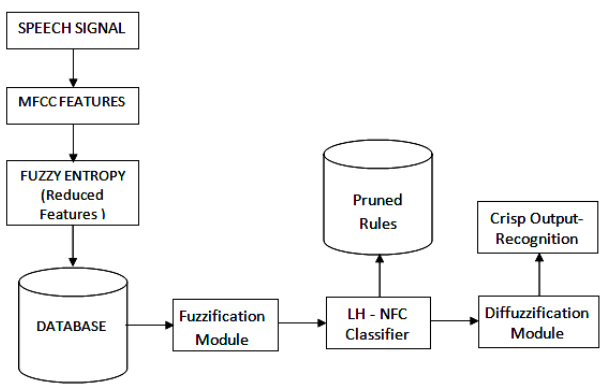
Figure 1. Block diagram of